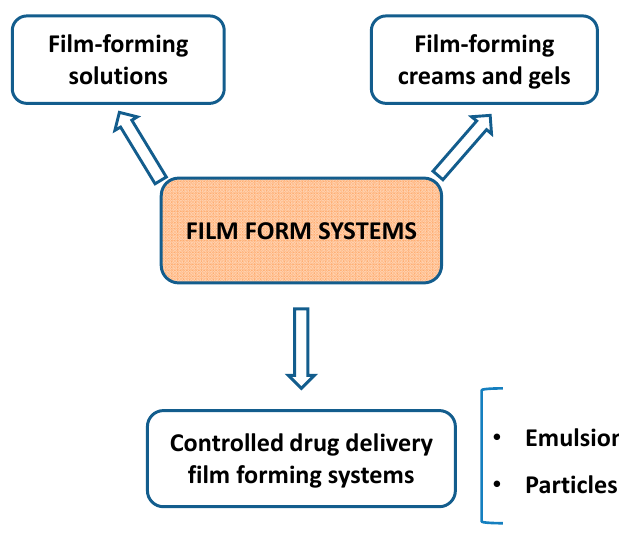
Figure 2. Illustrations of the generation of film-forming systems.